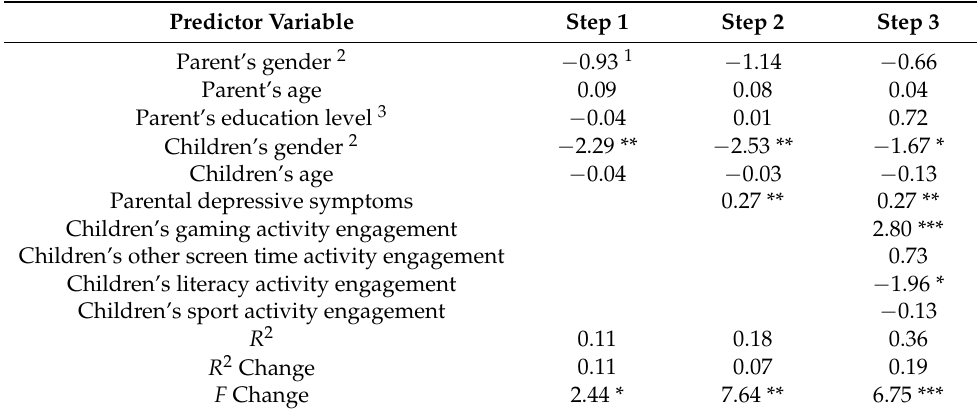
Table 5. Hierarchical regression model testing the role of demographic variables, parental depressive symptoms, and leisure activity engagement on children’s GD symptoms ( n =